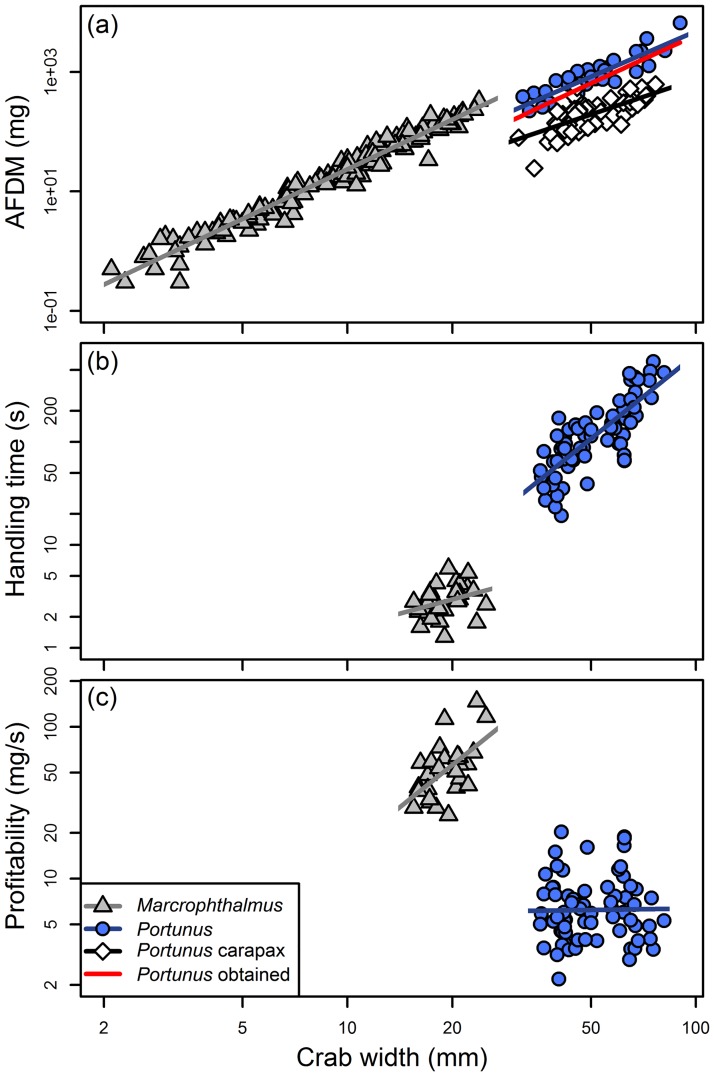
(a) AFDM (ei) plotted versus crab width (mm) (note the logarithmic axes). Grey triangles represent Macrophthalmus and blue dots represents Portunus. Non-filled rhombs represent the amount of AFDM (ei) that was left in depredated carapaxes of Portunus. The amount left in the carapaxes in terms of AFDM (ei) was subtracted from the AFDM (ei) of intact Portunus, yielding the amount of AFDM (ei) obtained by crab plovers, superimposed with a red line. For formulas see Table 1. (b) Handling time (hi) plotted versus crab width (mm) (note the logarithmic axes). Handling time does not increase significantly with size for Macrophthalmus (superimposed with a grey line), while for Portunus handling time significantly increases with size (superimposed with a blue line). For formulas see Table 1. (c) Profitability (AFDM (ei) / handling time (hi)) plotted versus crab width (mm) (note the logarithmic axes). Grey triangles represent Macrophthalmus and blue dots represent Portunus. Profitability significantly increases with size for Macrophthalmus (y = 0.22x1.85; superimposed with a grey line), while for Portunus profitability does not significantly increase with size (y = 5.46x0.03; superimposed with a blue line).